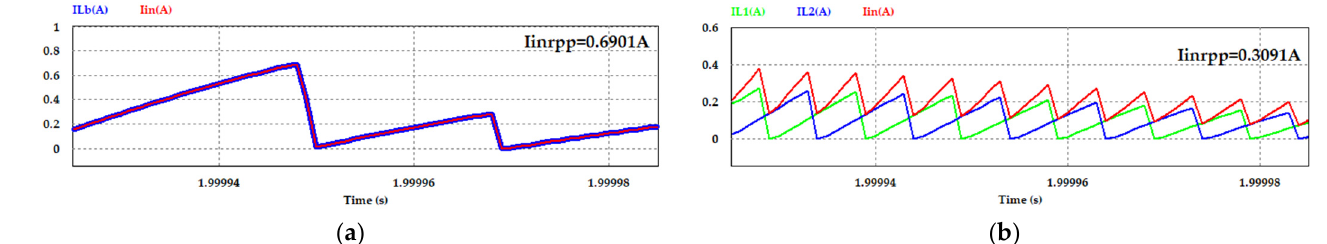
Figure 20. Input ripple current measurements: ( a ) conventional boost PFC; ( b ) interleaved boost PFC.